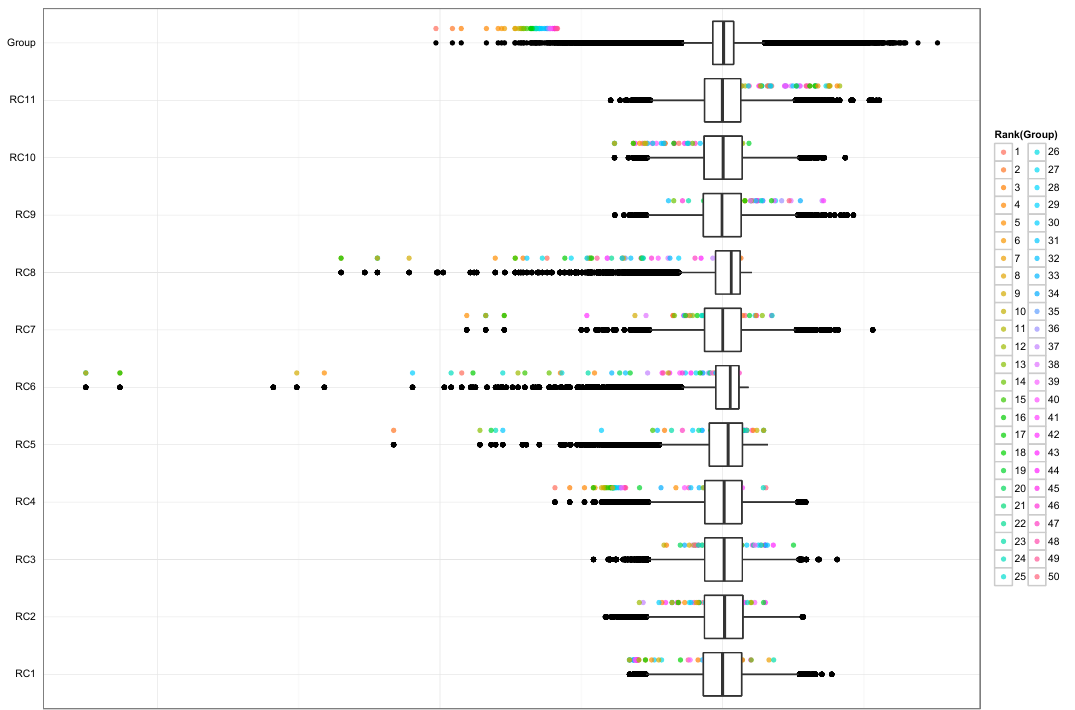
Figure 1. The sequence of box plots and related outliers represent distributions from eleven risk categories that are aggregated and displayed in the first box plot from above. The coloured points above the box plot for the aggregate depict the fifty worst case scenarios. These worst case scenarios are traced back to the risk categories by coloured dots. As the graphs show, these fifty worst cases for the aggregate are not necessarily located in the tail for the contributing risk categories. Hence, the risk management cannot only focus on the tails but on the whole distribution function. The Wasserstein distance fits to this need in a very particular